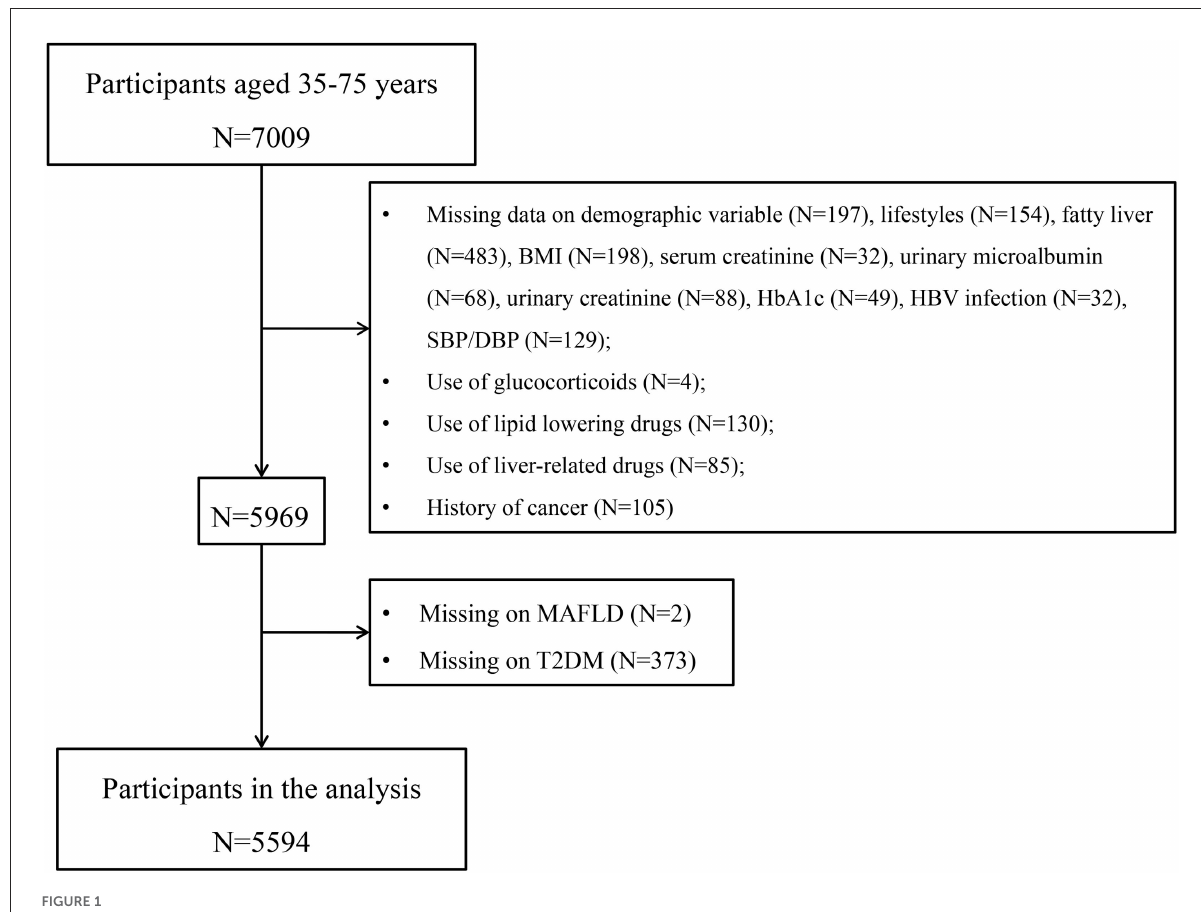
FIGURE1 Flowchart of selection of study